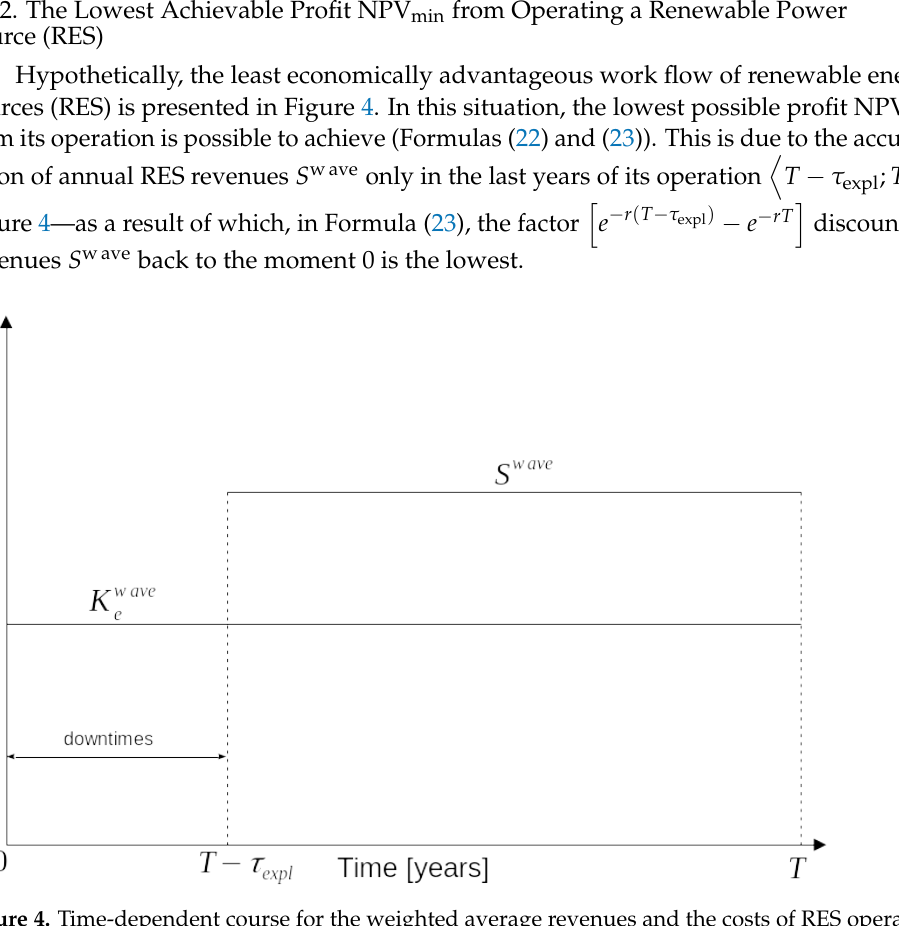
Figure 4. Time-dependent course for the weighted average revenues and the costs of RES operation for the hypothetically least advantageous variant of their